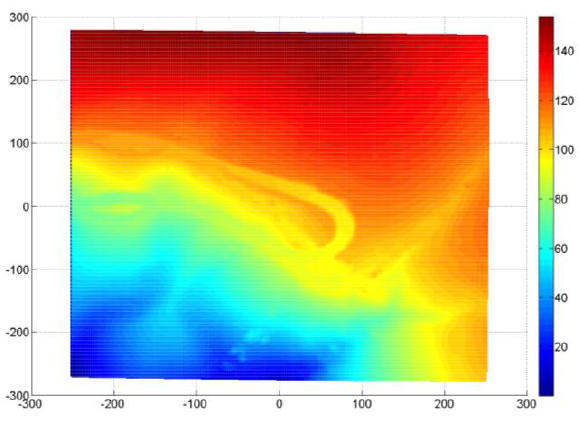
Figure 8. DEM with cell resolution of 2 m.